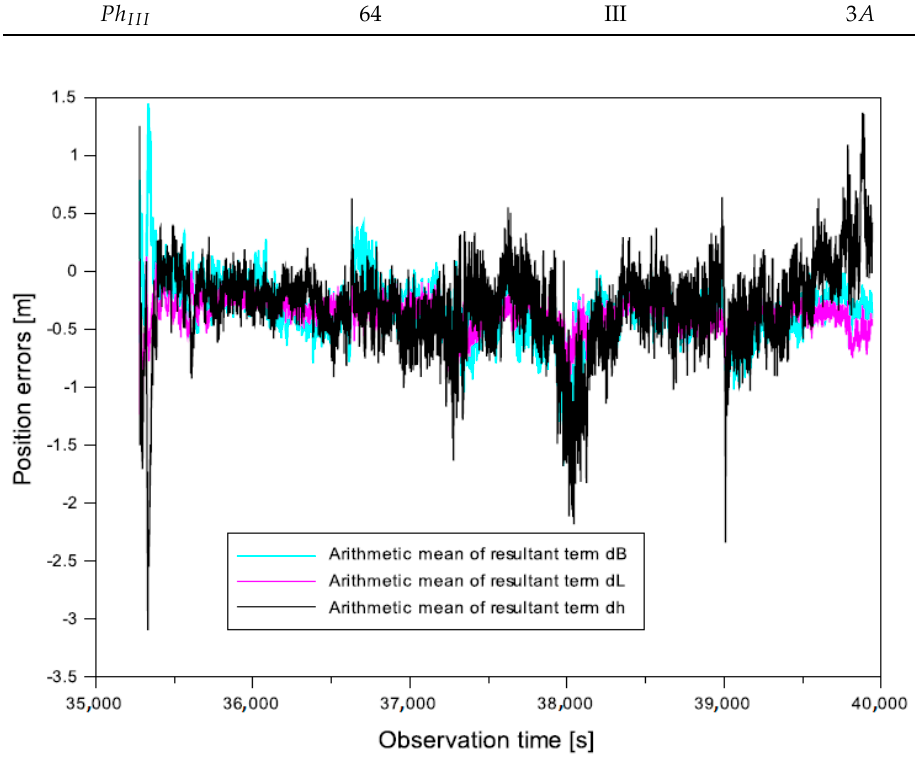
Figure 24. The arithmetic mean of parameters ( dBw , dLw , dhw )